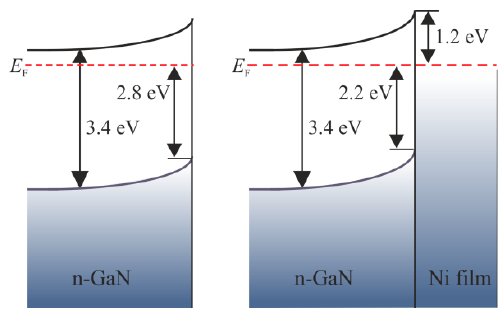
Figure 20. Energy band diagrams for a Ni ‐ film ‐ covered GaN(0001) surface.